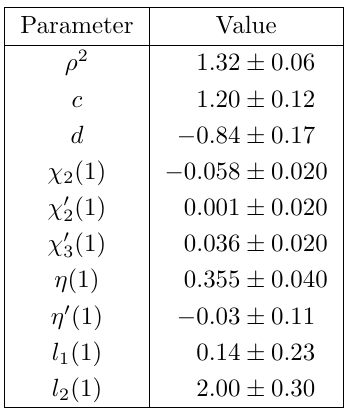
Table 1 . Inputs used to determine the form factors in the HQET parametrization as in [16]. The (cid:12)rst three parameters determine the leading Isgur-Wise function, while the last seven enter in the 1 =m c;b and 1 =m 2 corrections. The correlations between these parameters can be found in table 11 c of appendix